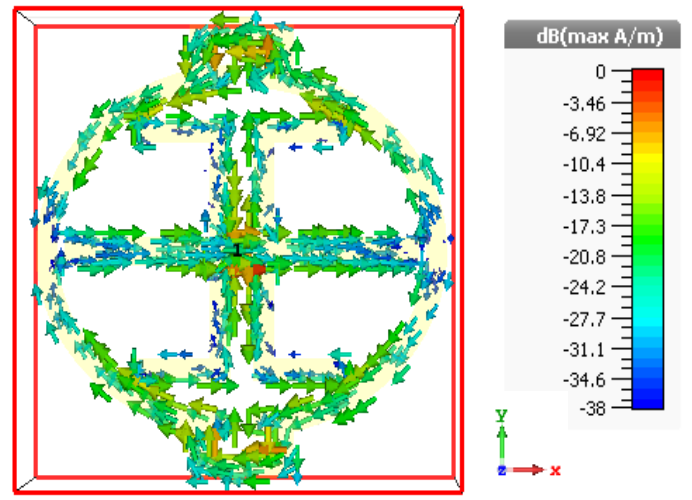
Figure 3. Surface current distribution at resonance frequency 3.914 GHz.